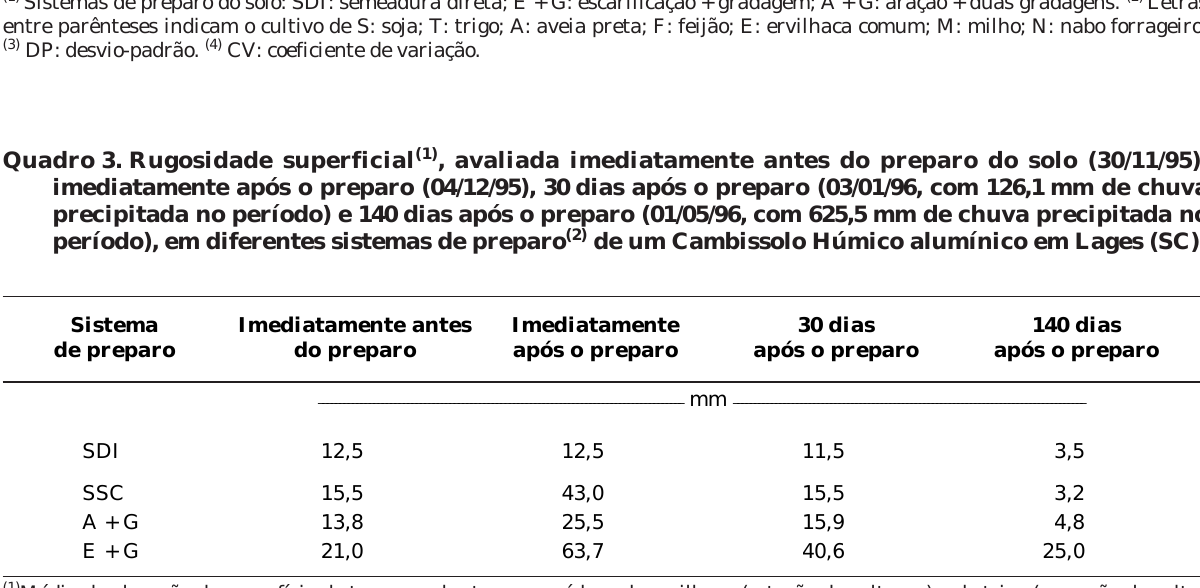
(1) Média da elevação da superfície do terreno coberto com resíduos de ervilhaca (rotação de culturas) e de trigo (sucessão de cultu- ras). (2) Sistemas de preparo do solo: SDI - semeadura direta; SSC - solo sem cultura+aração + duas gradagens; A + G - aração +